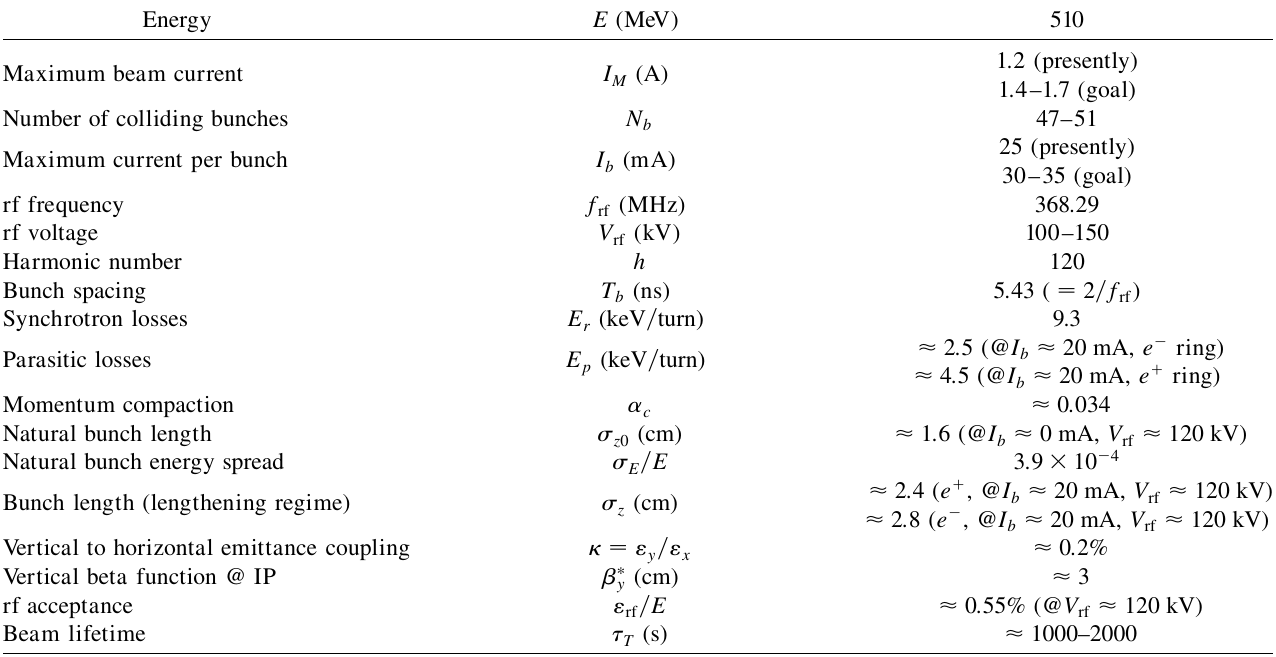
DA(cid:3)NE parameters (KLOE runs 2002).